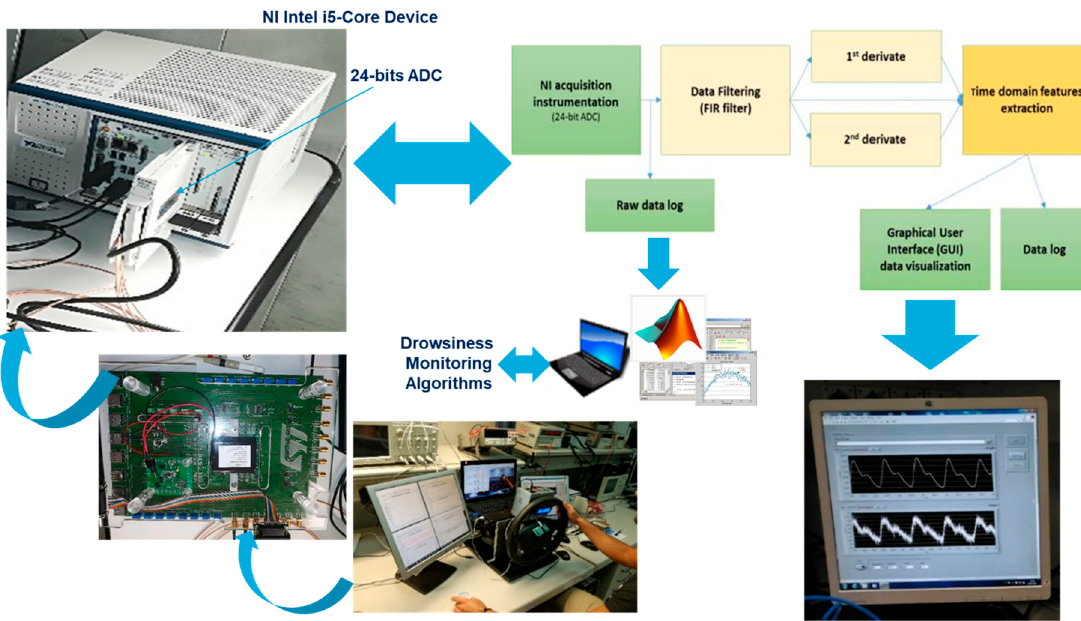
Figure 5. The PPG signal sampling hardware/software pipeline overview. NI, national instrument; FIR, finite impulse response.